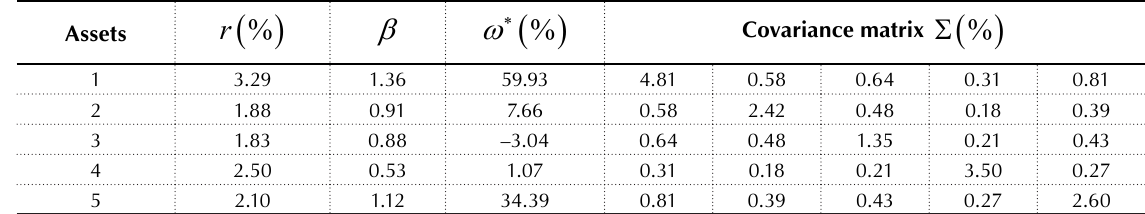
Table 2. Market parameters and optimal solution for the unconstrained EIT problem